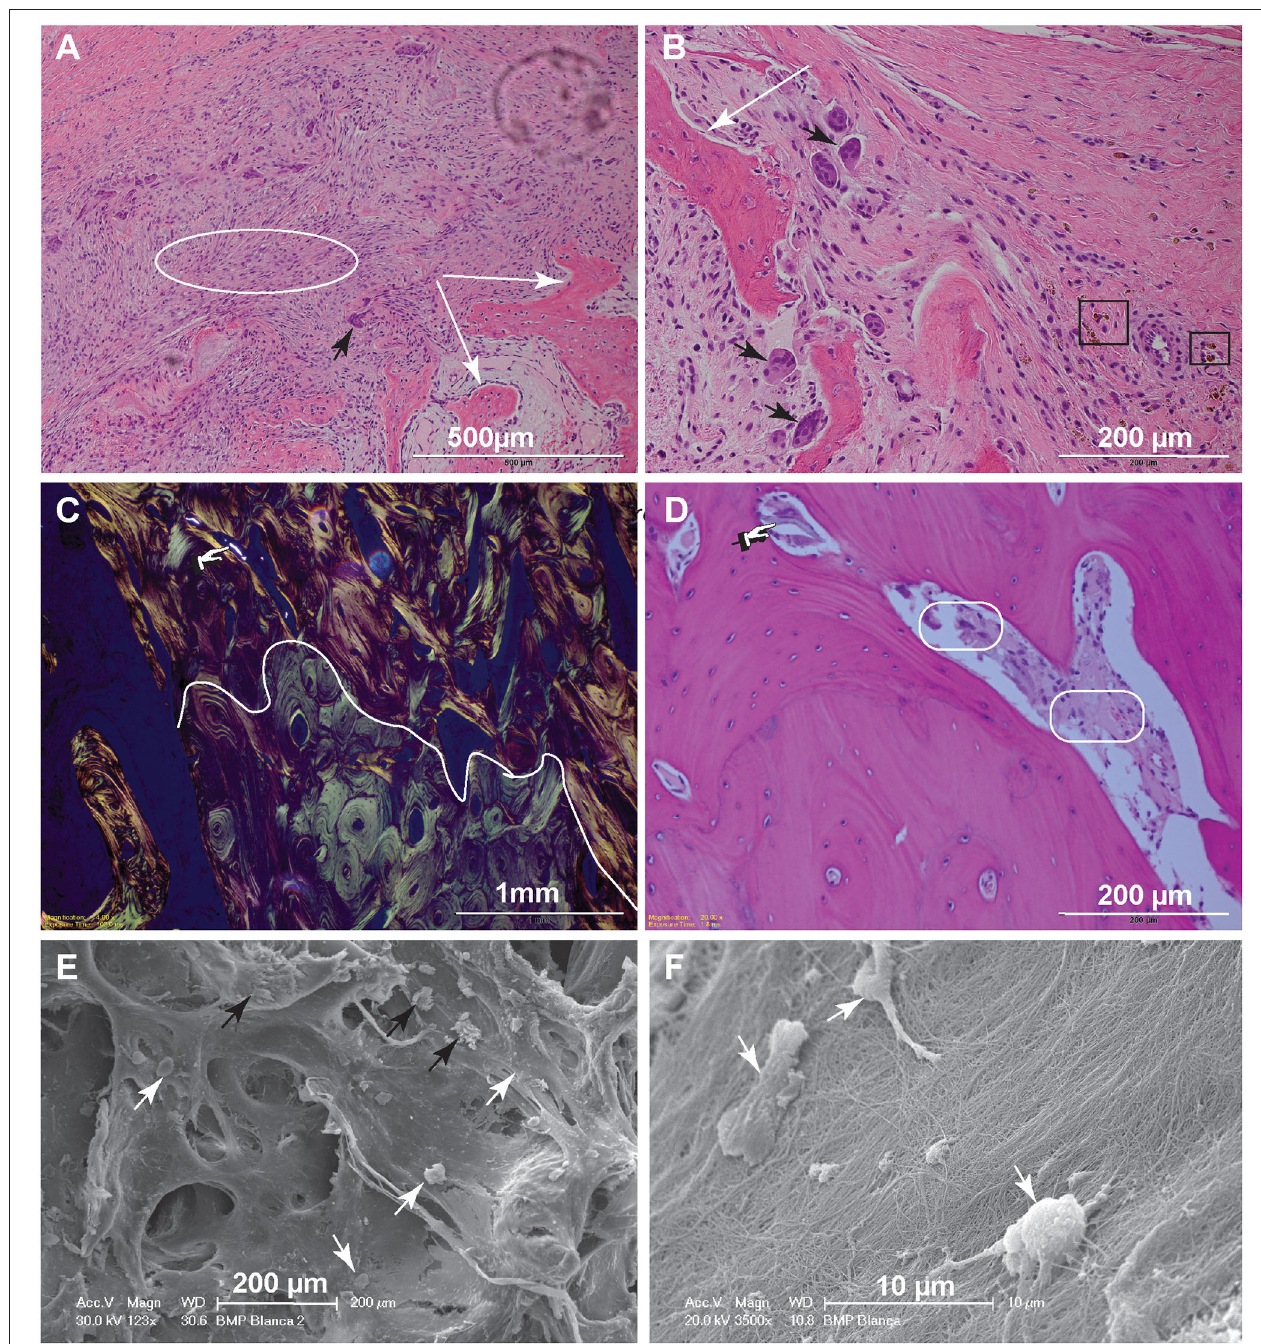
FIGURE 4 | Histopathology and SEM. (A) Low magnification image of the biopsy of dog 5, 1-month postoperative. The woven bone trabeculae (white arrows) are outlined by osteoblasts and contain intertrabecular loose fibromatous matrix. Active bone remodeling is evident by the presence of osteoclasts (large multinucleated cells) (black arrow) (bar = 500 µ m). (B) High magnification image highlighting multiple resorption lacunae occupied by large reactive osteoclasts (black arrows). Hemosiderin–laden macrophages, shown in the black rectangles, indicate historic hemorrhage (bar = 200 µ m). (C) Low magnification image of the biopsy from dog 10, 6-months postoperatively. This polarized image of bone demonstrates a clear delineation of pre-existing lamellar bone with osteons characterized by circumferential arrangement of collagen fibers (bottom of the curvy line) and immature (woven) bone with collagen fibers arranged in more chaotic pattern (above the curvy line). The refractile material is consistent with remaining CRM (bar = 1mm). (D) High magnification image of woven bone from image (C) . Note the lose fibrous connective tissue among the woven bone trabeculae (round corner white rectangles) and inorganic bone scaffold fragment (pointing finger) (bar = 200 µ m). (E) Scanning electron microscopy demonstrating woven bone with multiple resorption lacunae. The cells represent osteoclasts (black arrows), while more round cells are osteoblasts (white arrows) (bar = 200 µ m). (F) Higher magnification demonstrates the osteoblasts attached to the collagen fibers. The osteoblasts range in size, 7–10 µ m and have multiple cytoplasmic processes (bar = 10 µ